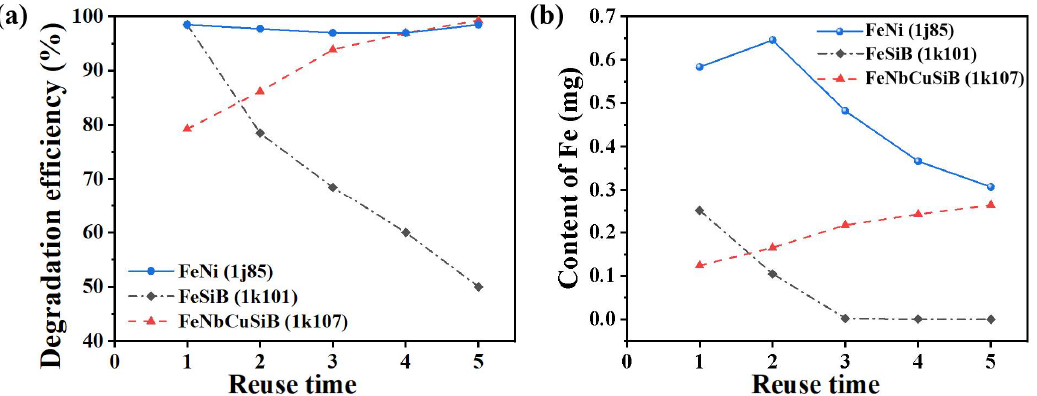
Figure 5. Reusability of the microreactors implanted with the 3 kinds of Fe-based sheets; ( a ) the degradation efficiency of the microreactors reused for 5 times; ( b ) the content of Fe in the reacted solution at different reused times.